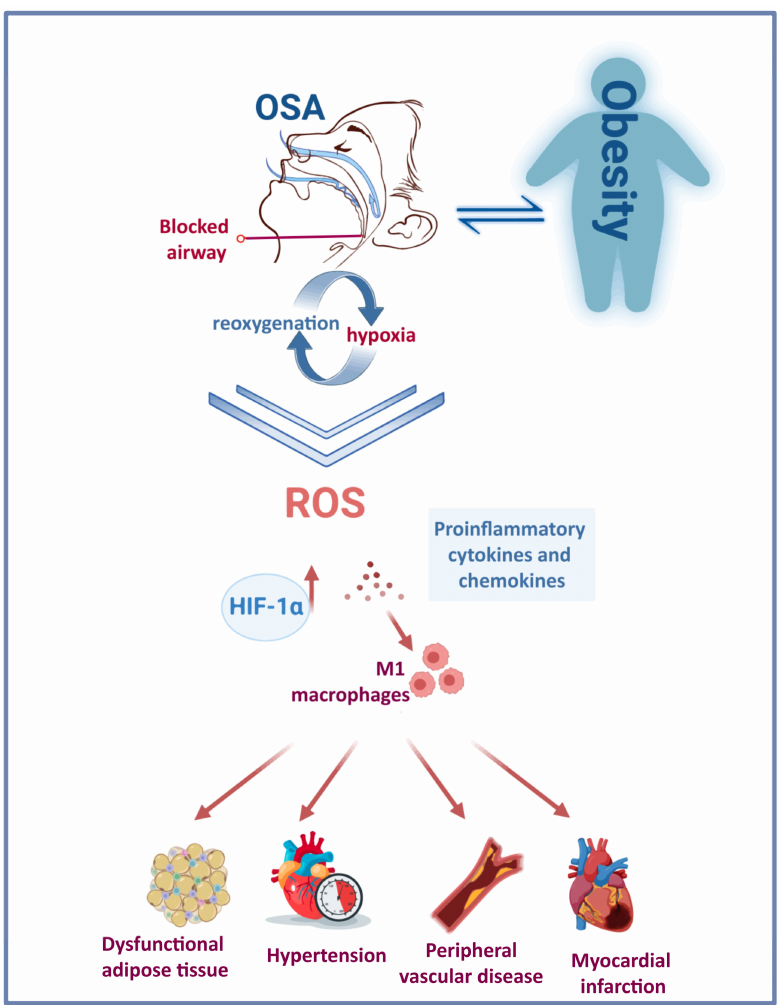
Figure 1. Obesity and OSA: a bidirectional interaction. The repetitive cycles of hypoxia-reoxygenation due to frequent blockage of the upper airway in people with OSA triggers the activation of various pathological mechanisms and induces a rise in HIF-1 α . The chronic presence of this condition has deleterious consequences on the cardiovascular